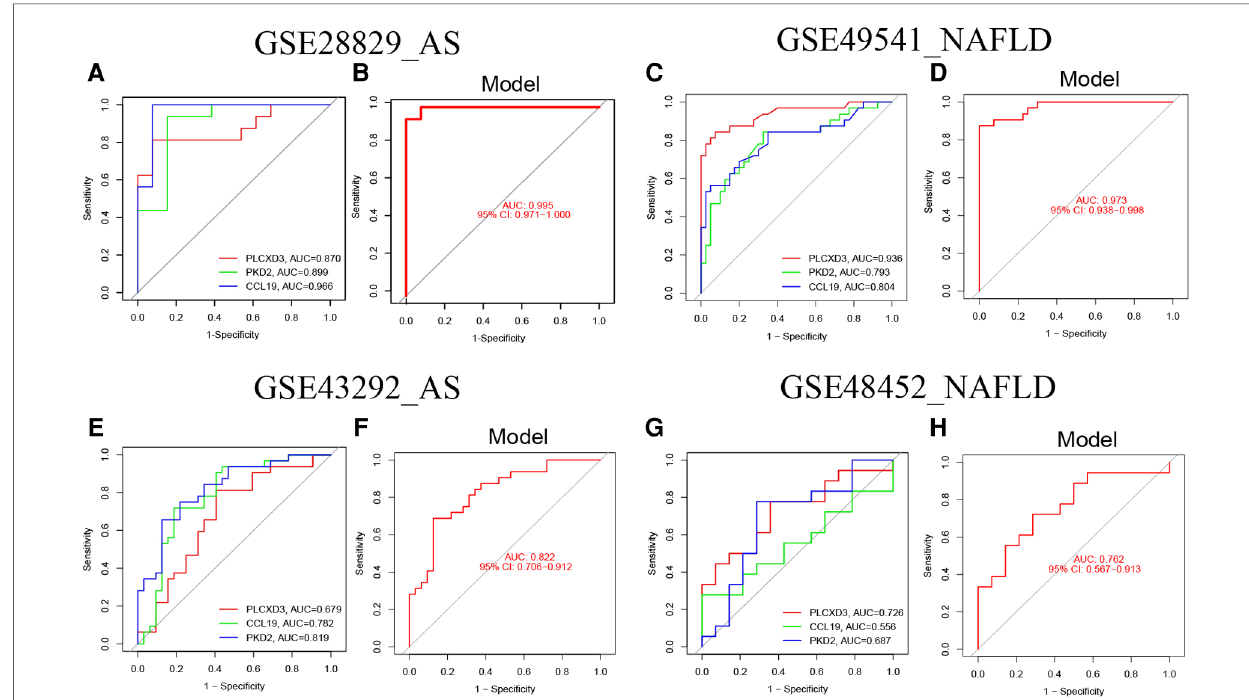
FIGURE 8 The validation of the nomogram models with ROC curves. ( A ) The ROC and AUC of each common signature gene in GSE28829; ( B ) the ROC and AUC of the nomogram model in GSE28829; ( C ) The ROC and AUC of each common signature gene in GES49541; ( D ) the ROC and AUC of nomogram model in GSE49541; ( E ) the ROC and AUC of each common signature gene in GSE43292; ( F ) the ROC and AUC of the nomogram model in GSE43292; ( G ) the ROC and AUC of each common signature gene in GES48452; ( H ) the ROC and AUC of the nomogram model in